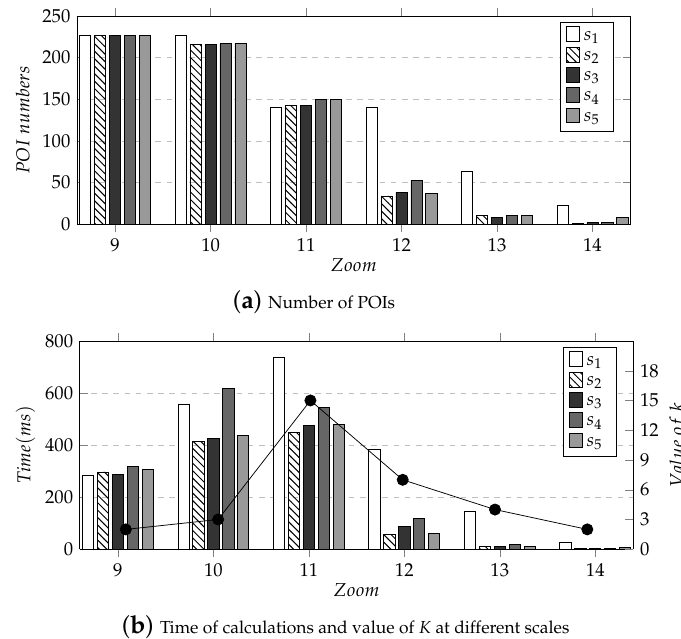
Figure 9. Number of POIs and run time of s 1 – s 5 in different